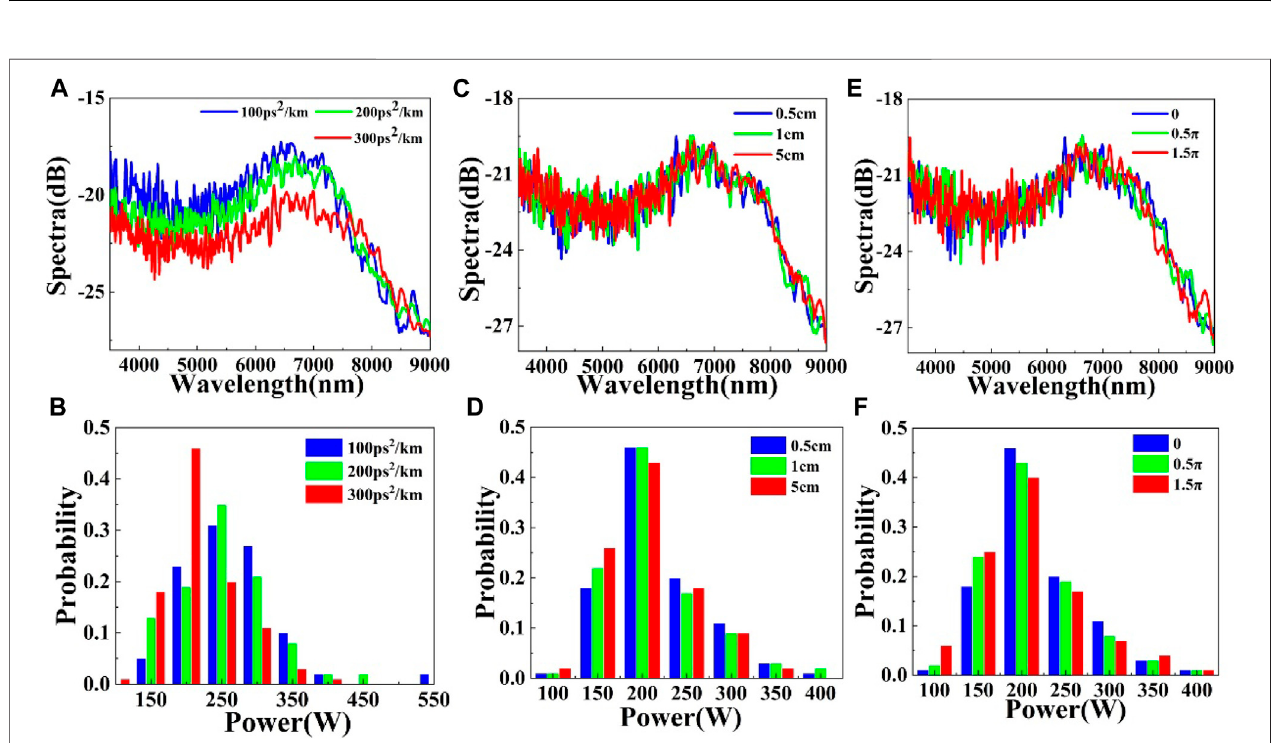
FIGURE 8 | (A,C,E) are the average of 100 output spectra, (B,D,F) are the peak power histograms of solitons corresponding to different oscillation amplitudes, periods and initial phases.